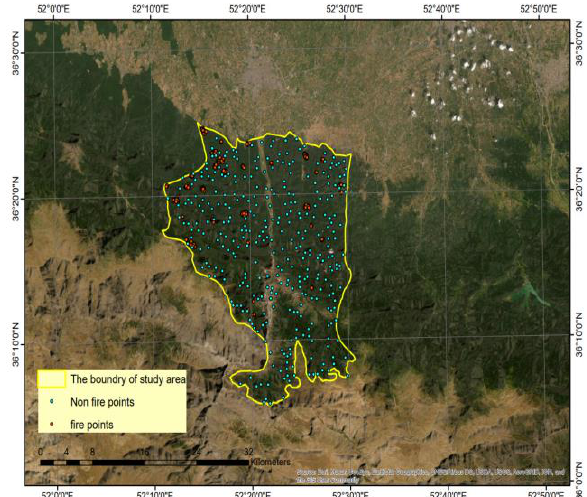
Figure 1 . Location map of the study